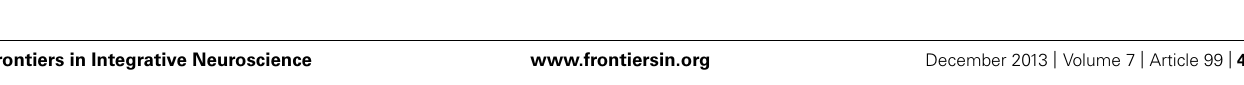
Frontiers in Integrative